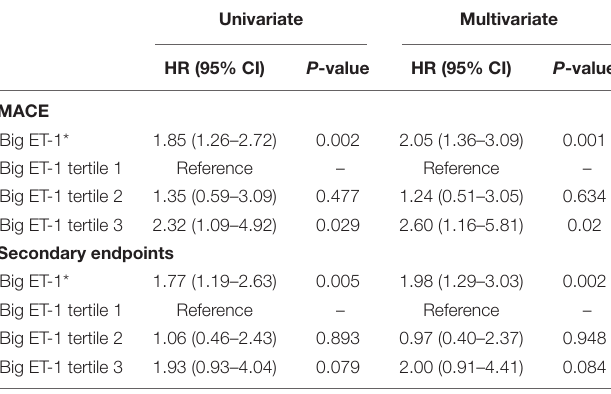
TABLE 4 | Cox proportional hazards models for prognosis in diabetic